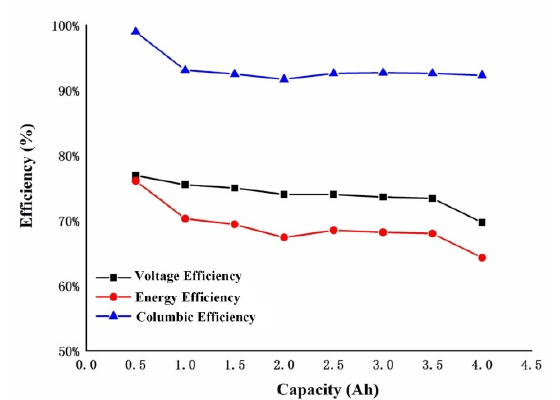
Figure 5. The e ffi ciency test results of the modular ZnBr 2 single Figure 5. The efficiency test results of the modular ZnBr 2 single cell.